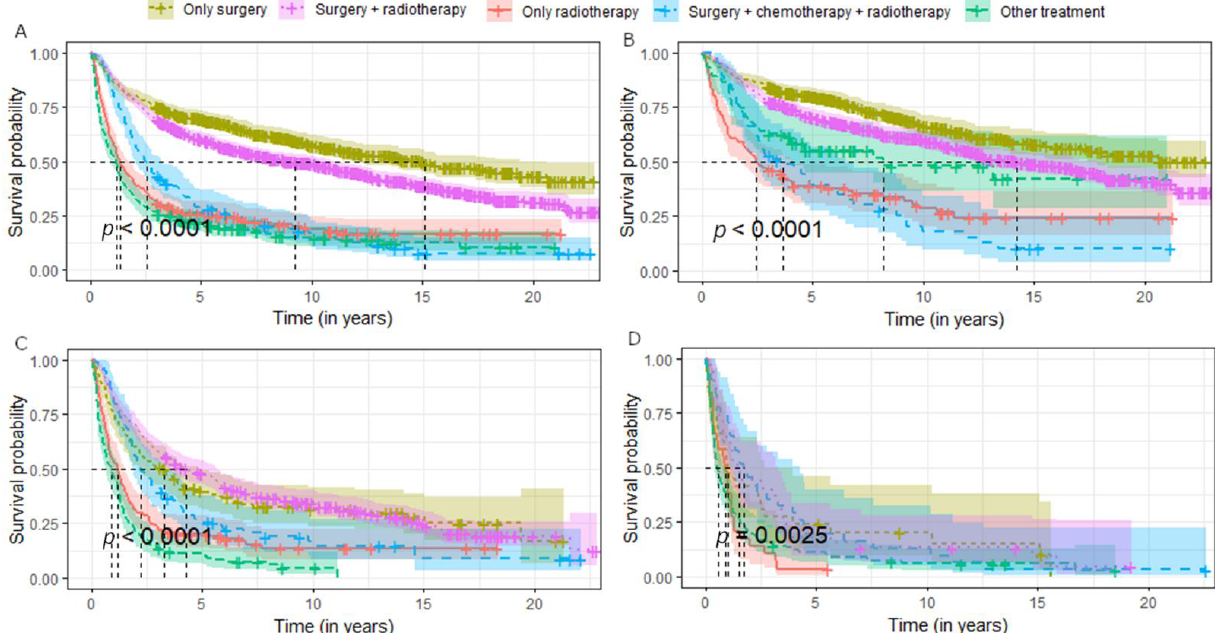
Figure 4. Survival of patients with parotid gland cancers stratified by treatment methods and stadium of the cancer: ( A ) all cancers, ( B ) regional stadium, ( C ) locoregional stadium, ( D ) systemic stadium.